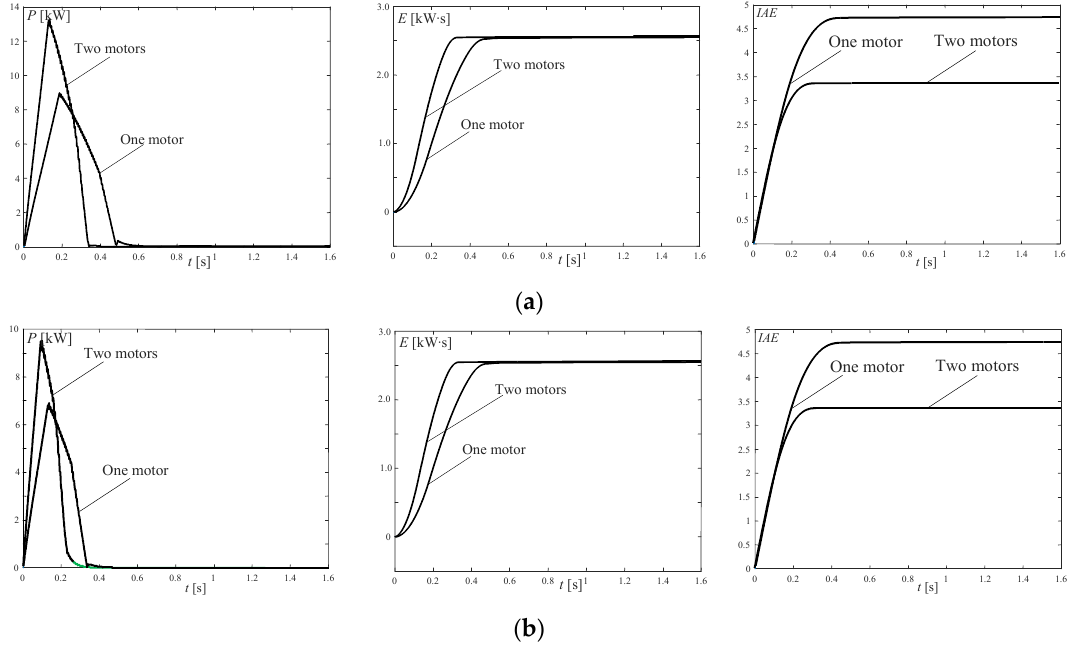
Figure 10. The valve power ( P ) and energy losses ( E ) and IAE curves recorded during step responses controlled by an overshot-free algorithm servo drive. ( a ) Assumed distance 20 mm. ( b ) Assumed distance 10 mm.